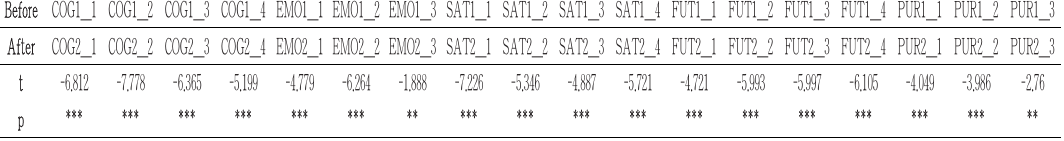
<Table 4> Results of the paired